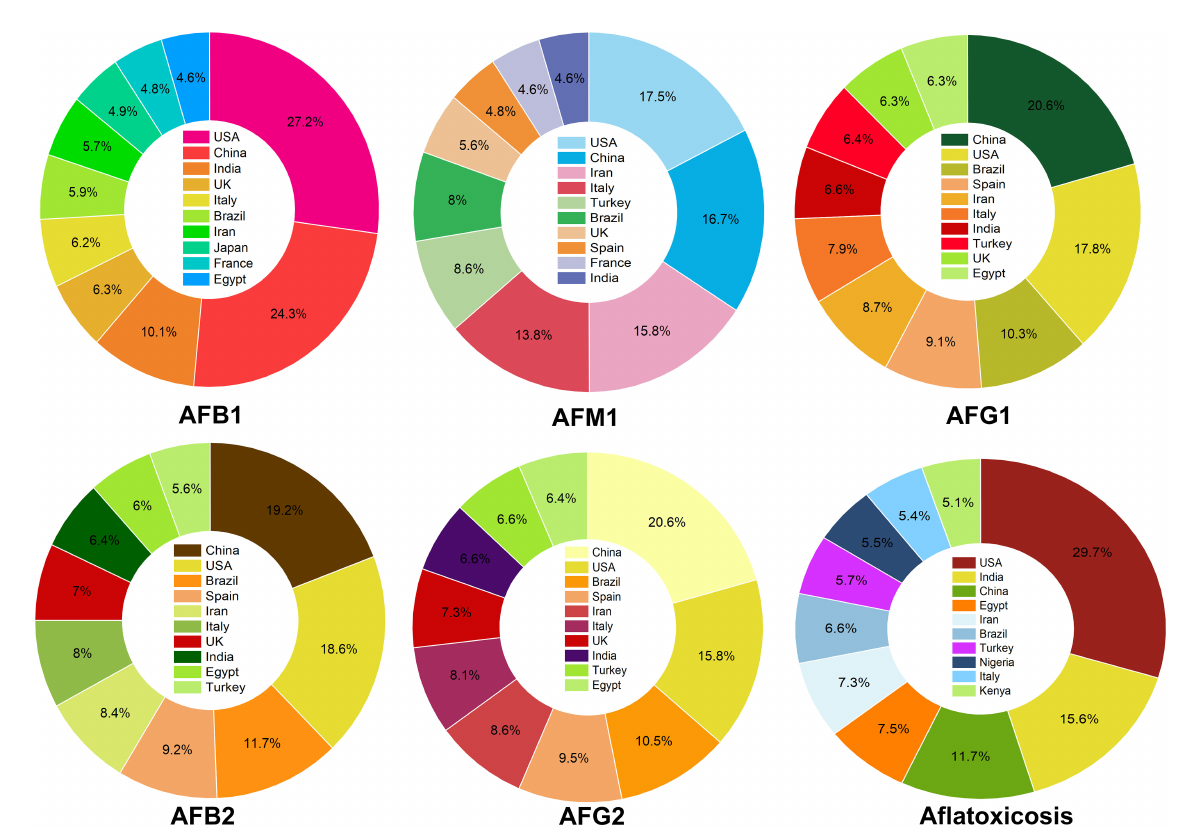
FIGURE4 The proportion of academic investigations on AFs. For each class of AFs metabolites, the percentage of published studies has shown for the top 10 countries.